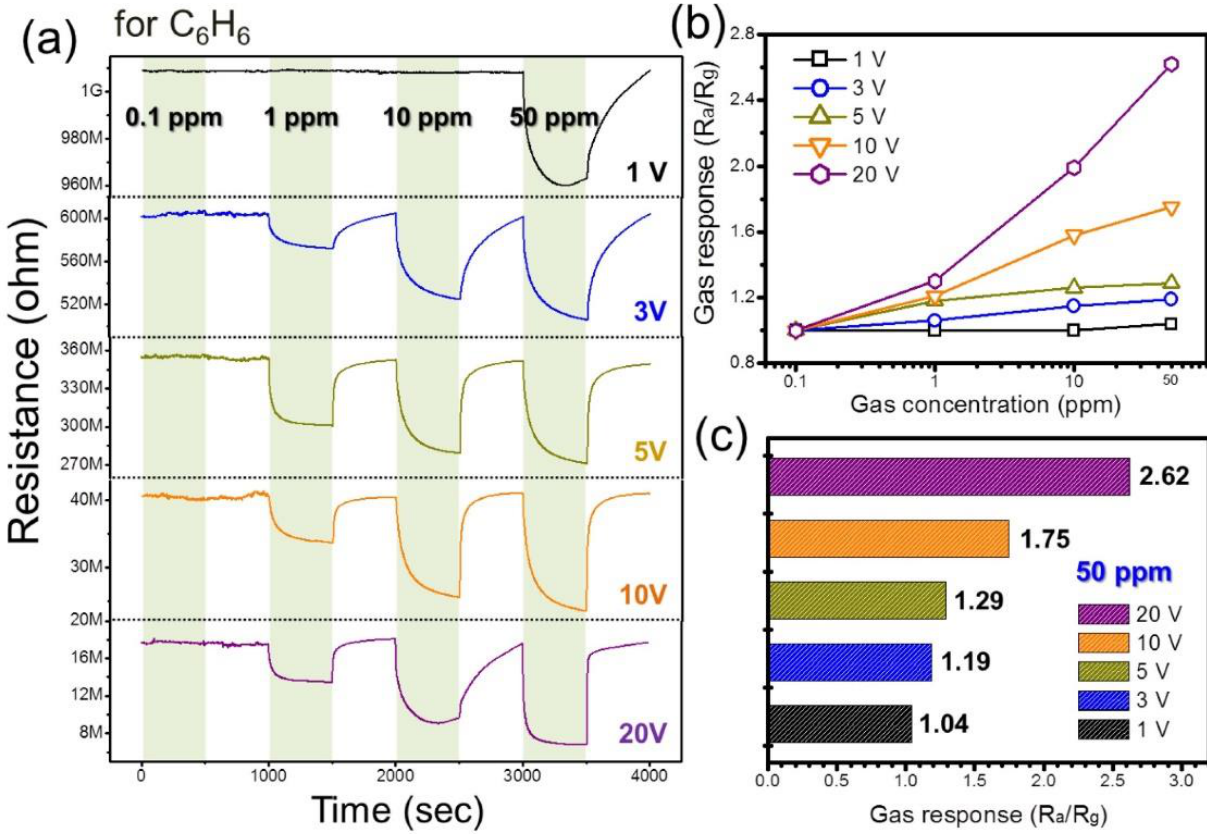
Figure 8. ( a ) Dynamic resistance curves of a Pd-functionalized SnO 2 –ZnO C–S NW sensor at different values of applied voltages, and 0.1–50 ppm C 6 H 6 , at room temperature. ( b ) Corresponding calibration curves at different applied voltages. ( c ) Comparison between responses to 50 ppm C 6 H 6 at different applied voltages. Reprinted with permission from Ref. [77]. Copyright 2020, Elsevier.